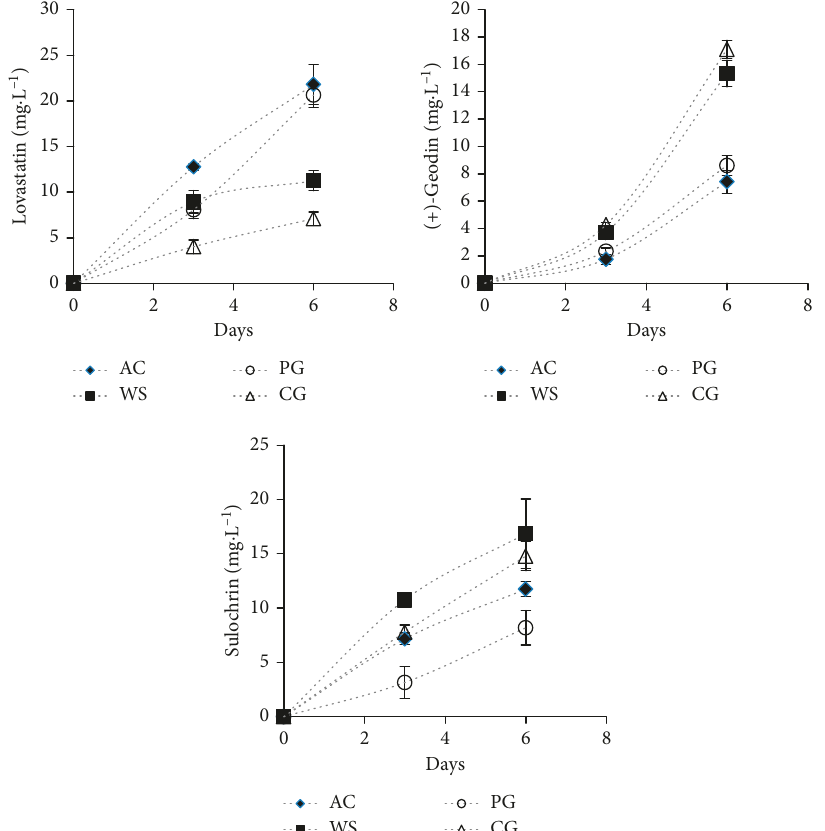
Figure 4: The production of lovastatin, (+)-geodin, and sulochrin by A. terreus under the treatment of AC and WS. Lovastatin, (+)-geodin, and sulochrin production in AC mirrored positive control (PG), while the metabolite production in WS mirrored negative control